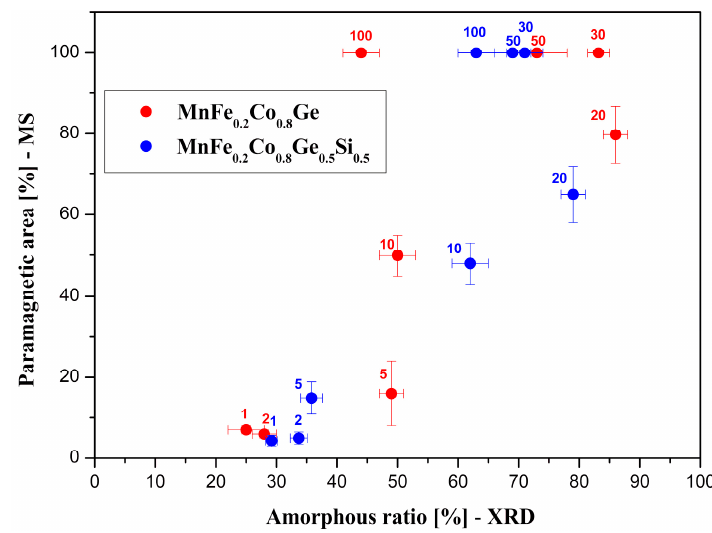
Figure 7. Amorphous fraction from XRD Rietveld analysis as a function of PM contribution from MS for Si-free alloy (in red) and Si-containing alloy (in blue). Numbers indicate the milling time in hours for each composition.